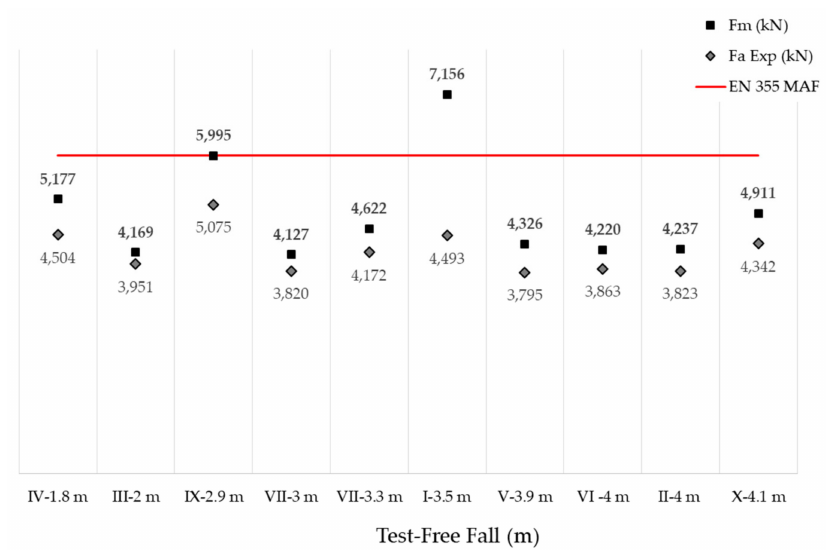
Figure 9. Freefall vs. maximum arrest force ( F m ) and average deployment